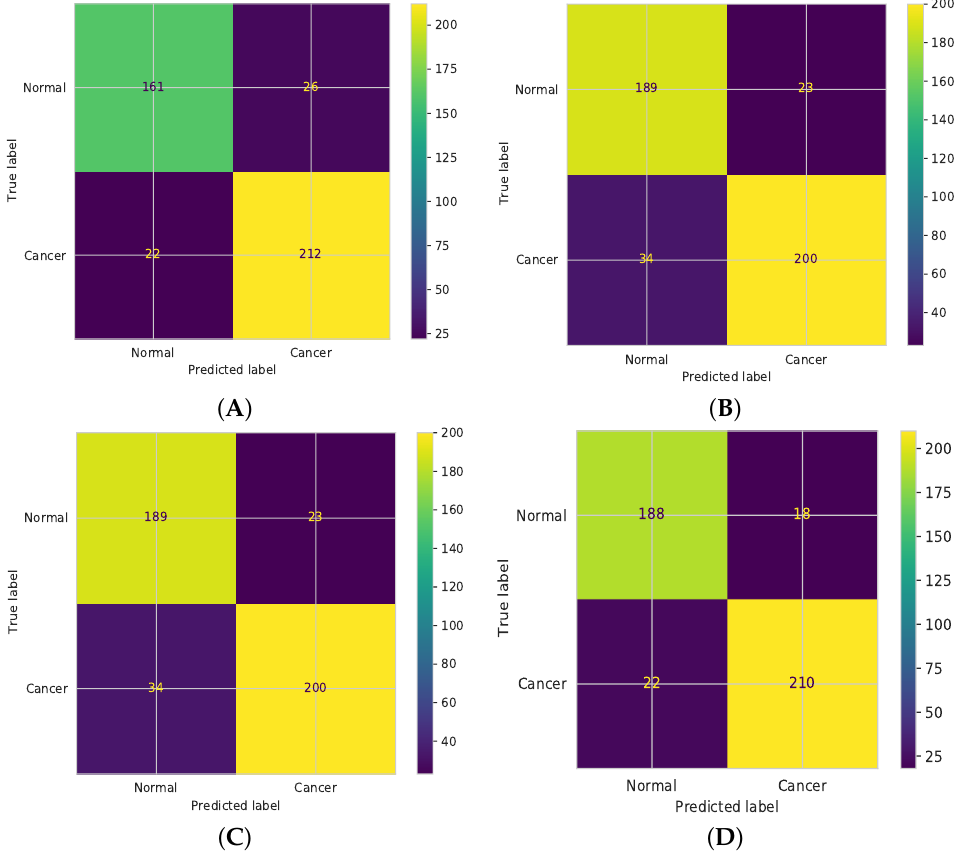
Figure 9. Confusion matrix for the four different magnification factors. ( A ) 40x. ( B ) 100x. ( C ) 200x. ( D )